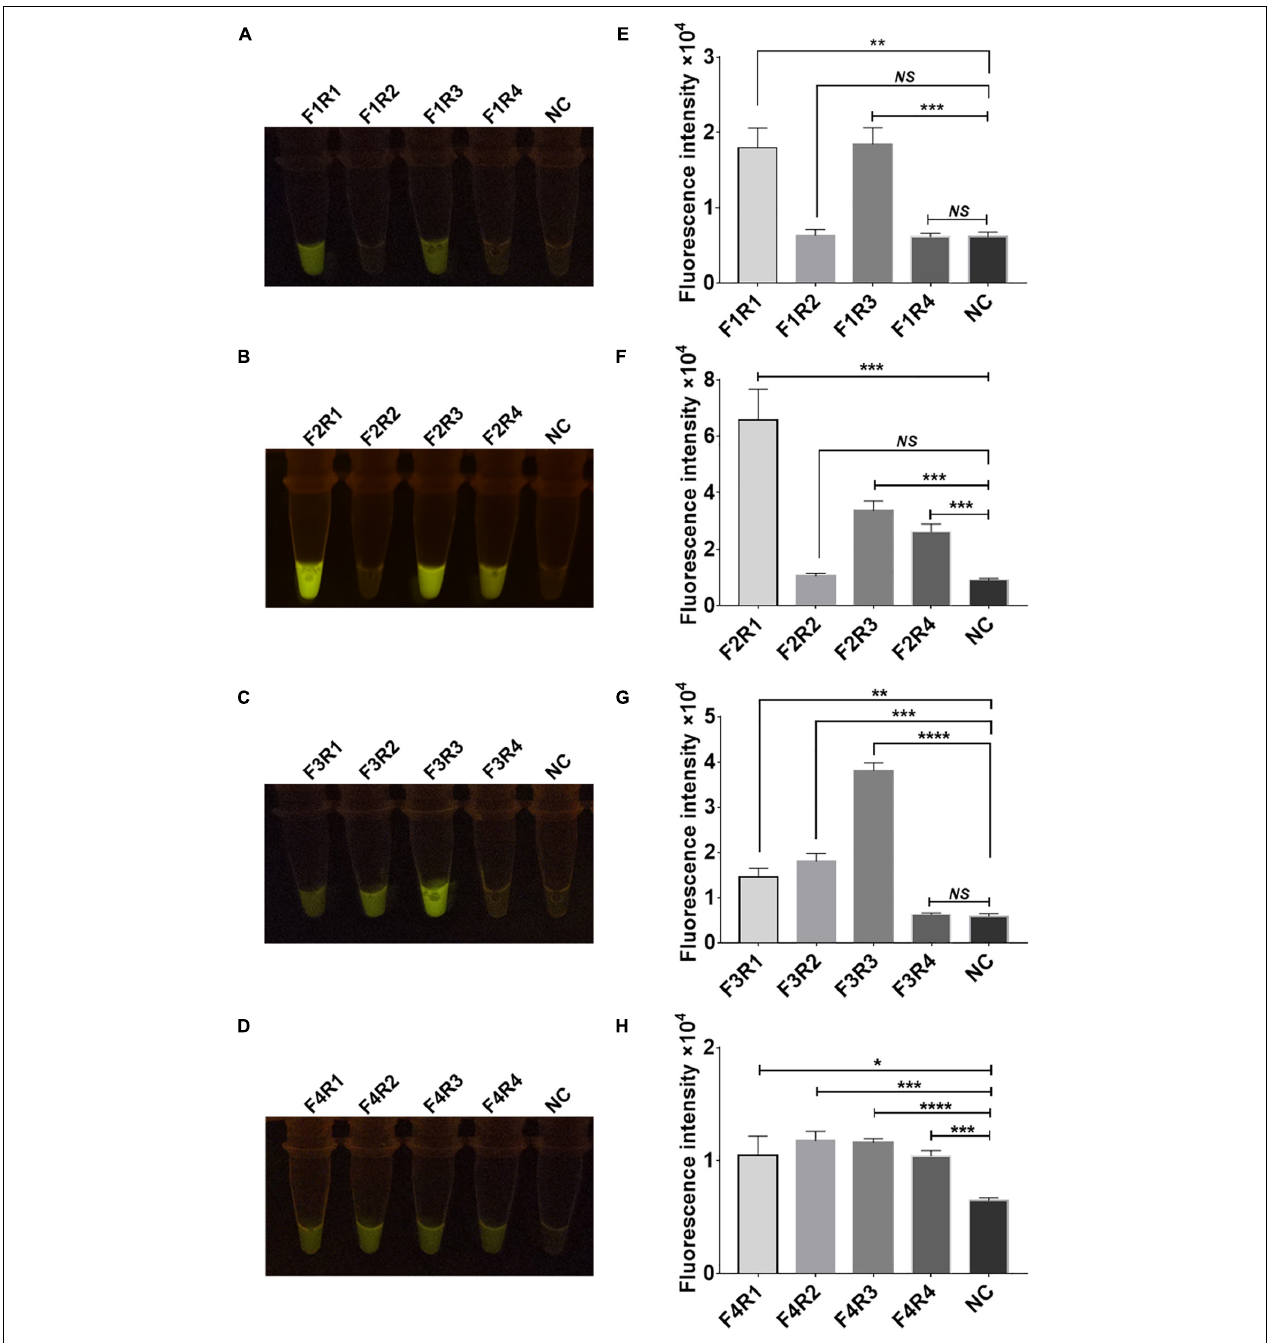
FIGURE 4 | Screening of recombinase polymerase amplification (RPA) primers for the rpsl gene of streptomycin (STR)-resistant M. tuberculosis . Optimization of high-efficiency RPA primers used to amplify the rpsl-related gene fragments of STR-resistant M.tb . The amplification efficiency of 16 pairs of RPA primers was evaluated; the fluorescent images (A–D) and fluorescence intensity (E–H) at 15 min of reaction are shown. The content of the STR-resistant M.tb whole-genome template used in the above-mentioned detection reaction is 100 ng. Data are presented as the mean ± SEM from at least three independent experiments. * p < 0.05, ** p < 0.01, *** p < 0.001, and **** p <